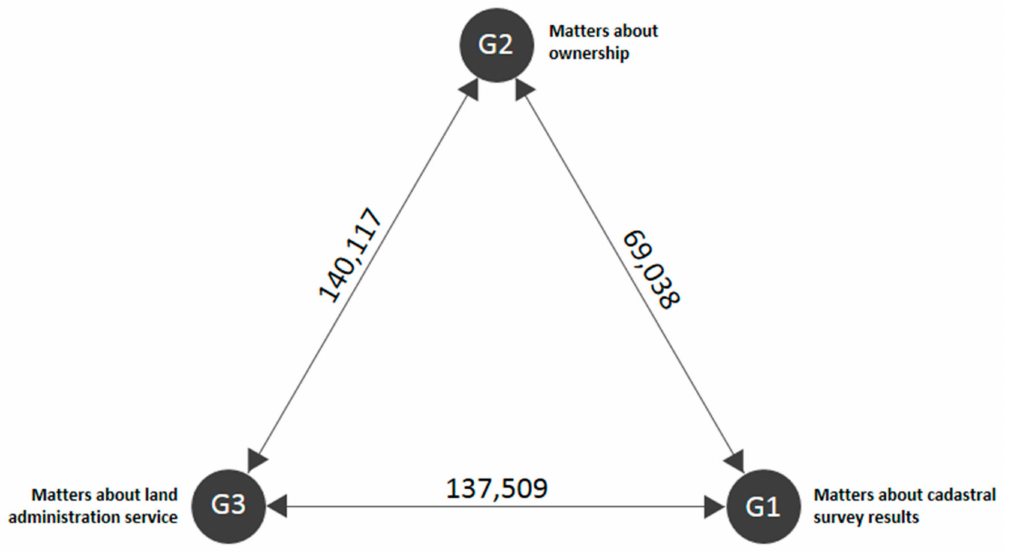
Figure 4. Two-mode Network.